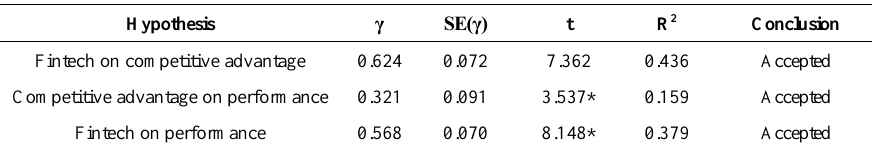
Table 3. Estimated measurement model parameters